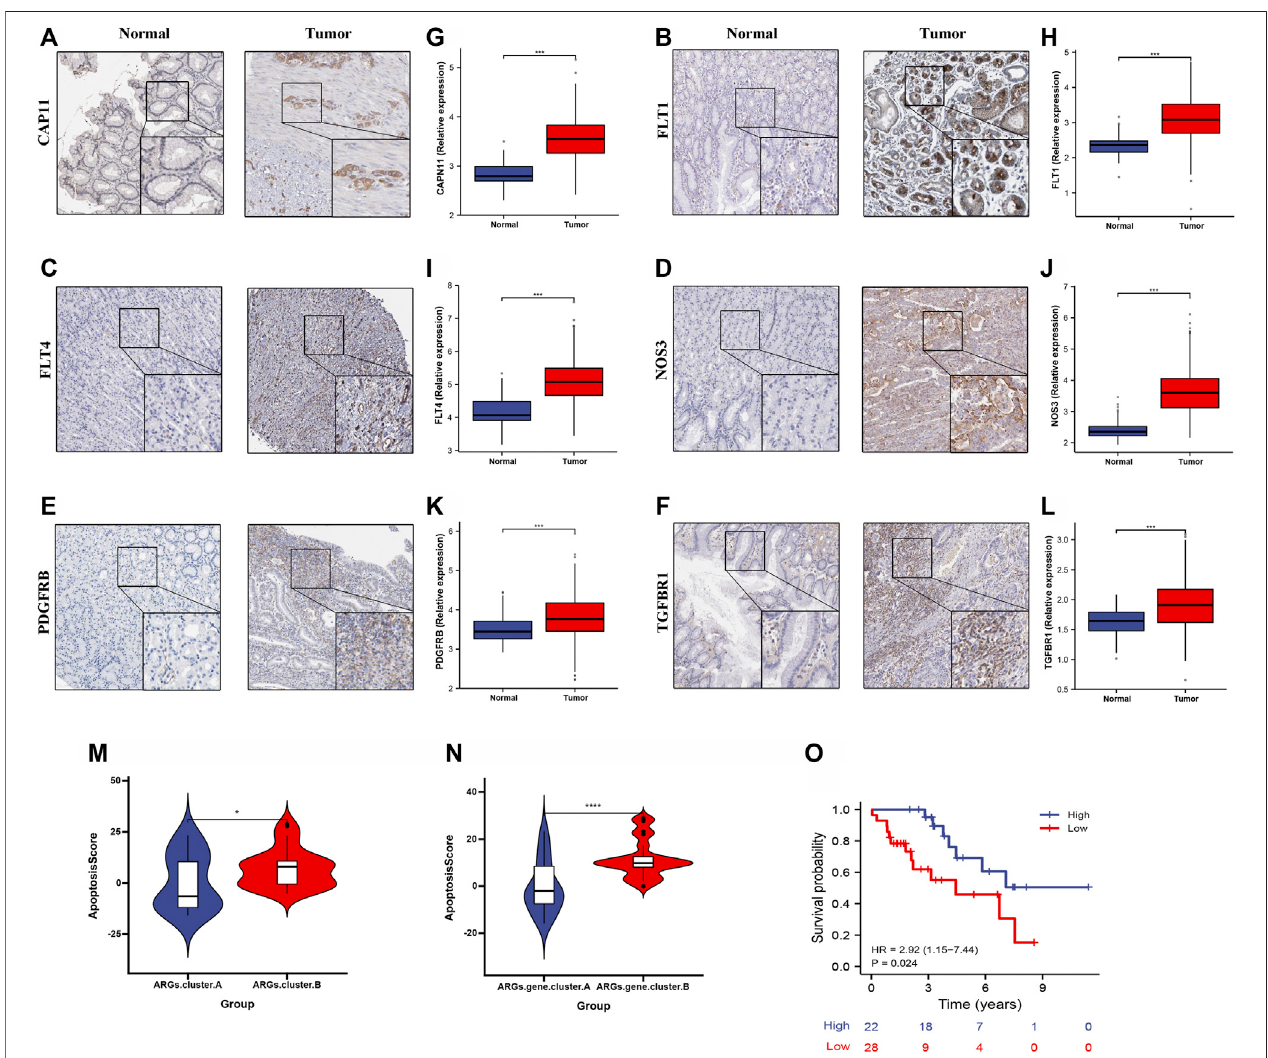
FIGURE10| TheexpressionandoverallsurvivalofsixARGsinGC. (A – F) RepresentativeimmunohistochemistryimagesofsixARGsexpressioninnormaltissues, and GC tissue. (G – L) six ARGs mRNA levels are shown for the GC and normal tissue. (M) Differences in apoptosisScore among two ARGs. (N) Differences in apoptosisScore among two ARGs.gene.clusters. (O) Kaplan-Meier analysis of overall survival based on apoptosisScore in 50 cases of GC patients.